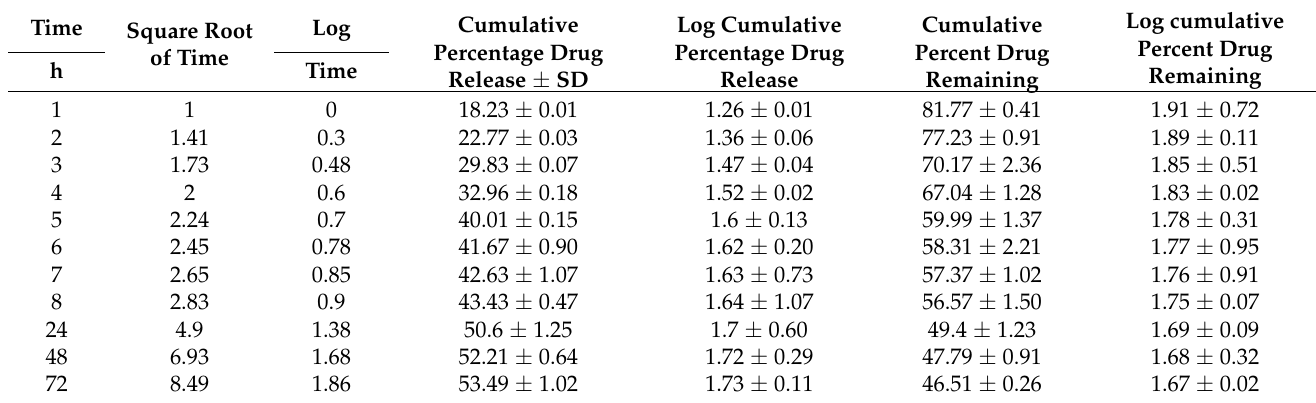
Figure 6. In vitro release profile of optimized MoP compared to free Mopp in phosphate-buffered saline pH 7.4 at 37 ± 0.5 °C (mean ± SD, n = 3). Table 3. In vitro drug release data for different kinetic models.